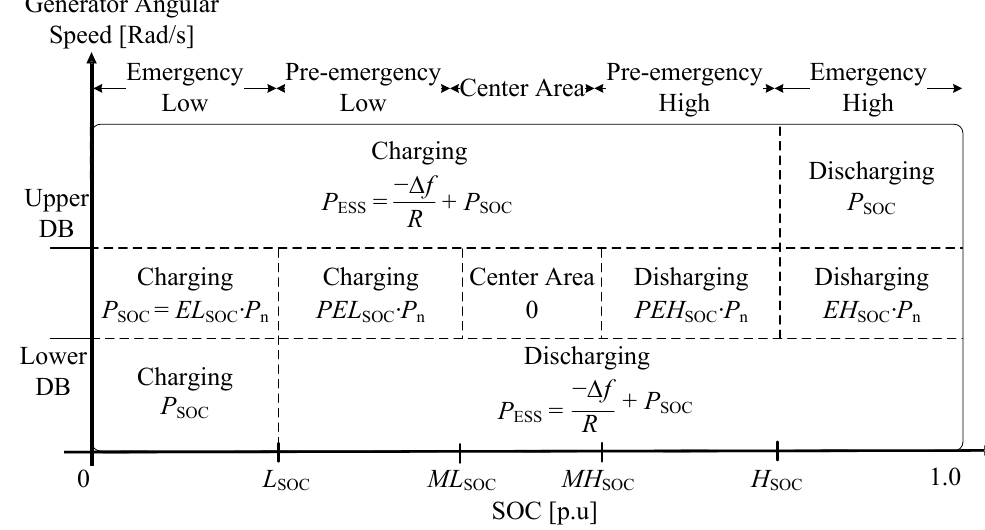
Figure 5. Algorithm table for ESS power determination based on angular speed (Gen.) and SOC